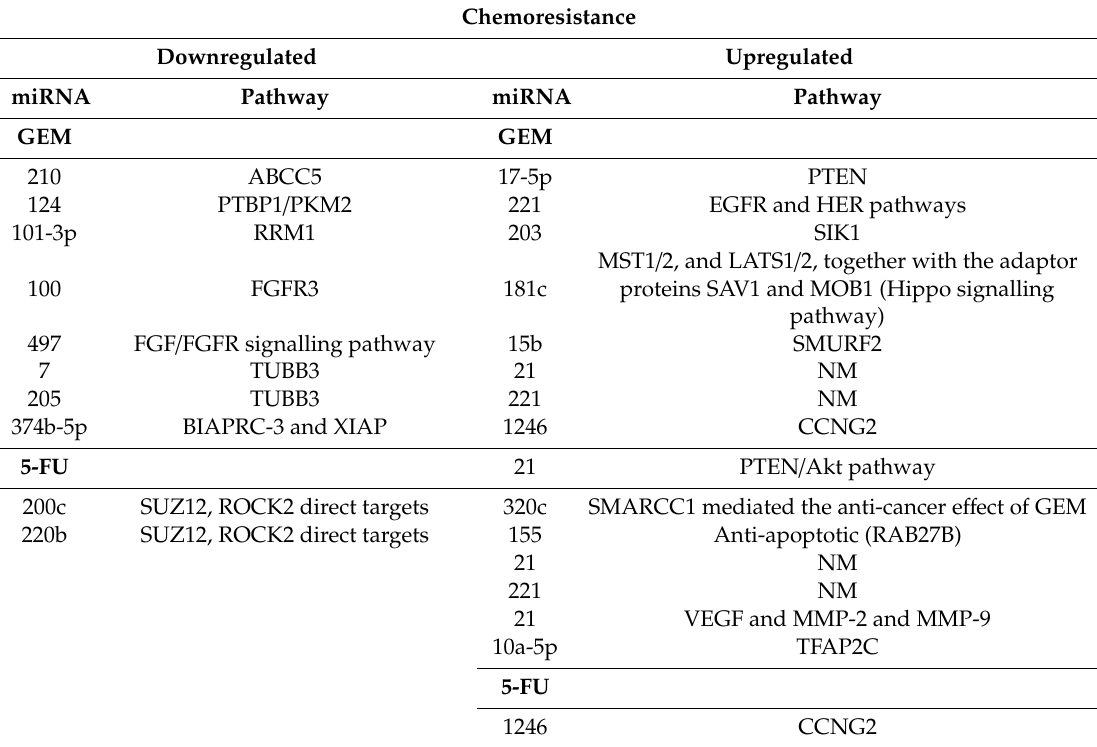
Table 2. miRNAs that are involved in chemoresistance and pathways that are modulated.